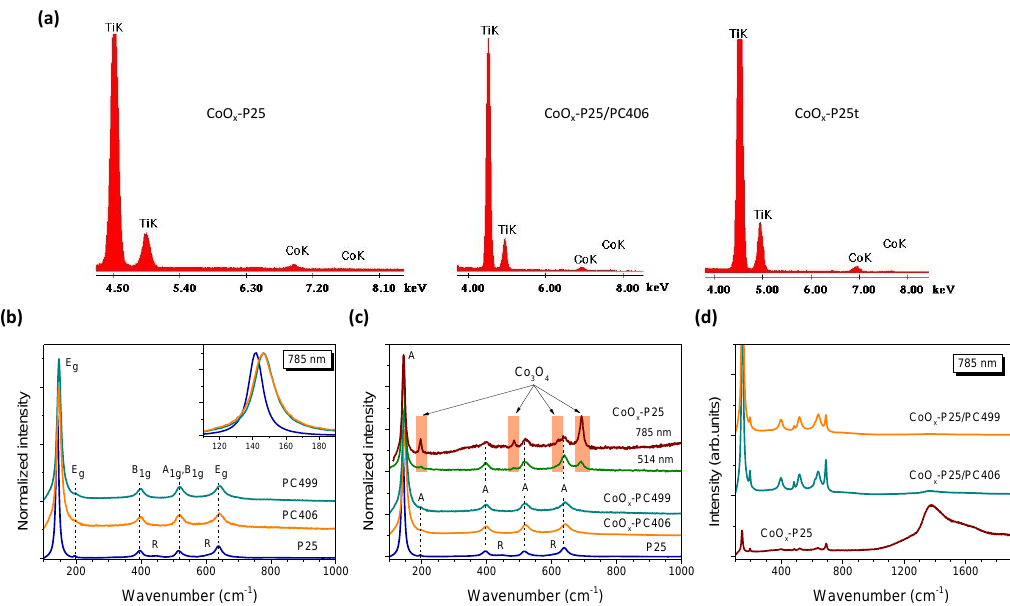
Figure 3. ( a ) Representative EDX spectra of the surface-modified CoO x -TiO 2 films. Raman spectra of monolithic PC and P25 films ( b ) before and ( c ) after CoO x deposition. The inset in ( b ) compares the corresponding low-frequency anatase E g modes, while arrows and shaded bands in ( c ) indicate the Co 3 O 4 spinel modes. ( d ) Comparative Raman spectra for the CoO x -P25 and bilayer films at 785 nm. On the other hand, the Co 3 O 4 bands were not detected for the CoO x -PC films, despite the